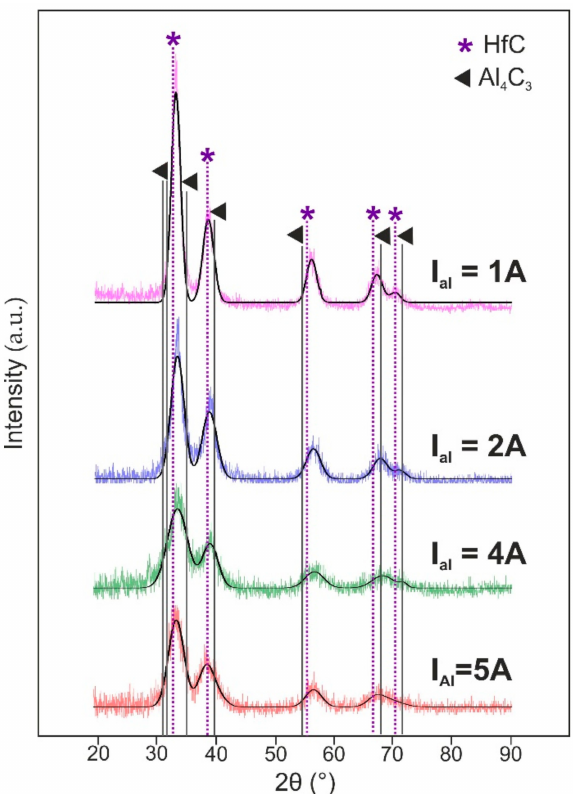
Figure 2. XRD patterns of Hf-Al-C films in dependence on the Al target discharge